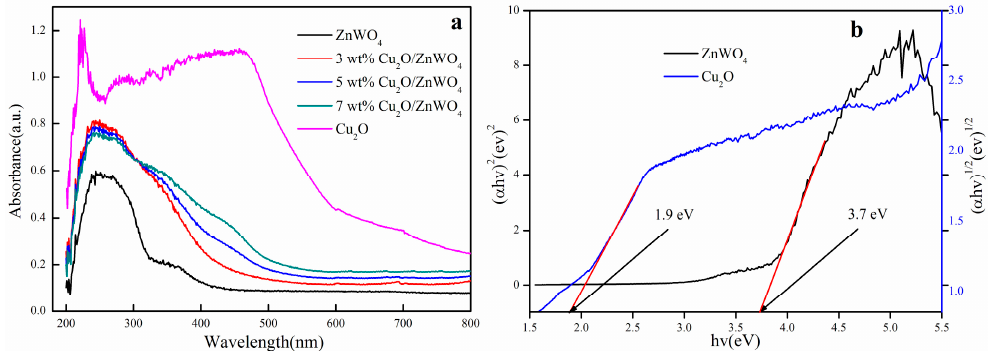
Figure 3. ( a ) UV-visible light (UV-vis) diffuses reflection spectra of pure ZnWO 4 , Cu 2 O and Cu 2 O/ZnWO 4 samples; ( b ) the band gap energies of ZnWO 4 and Cu 2 O.